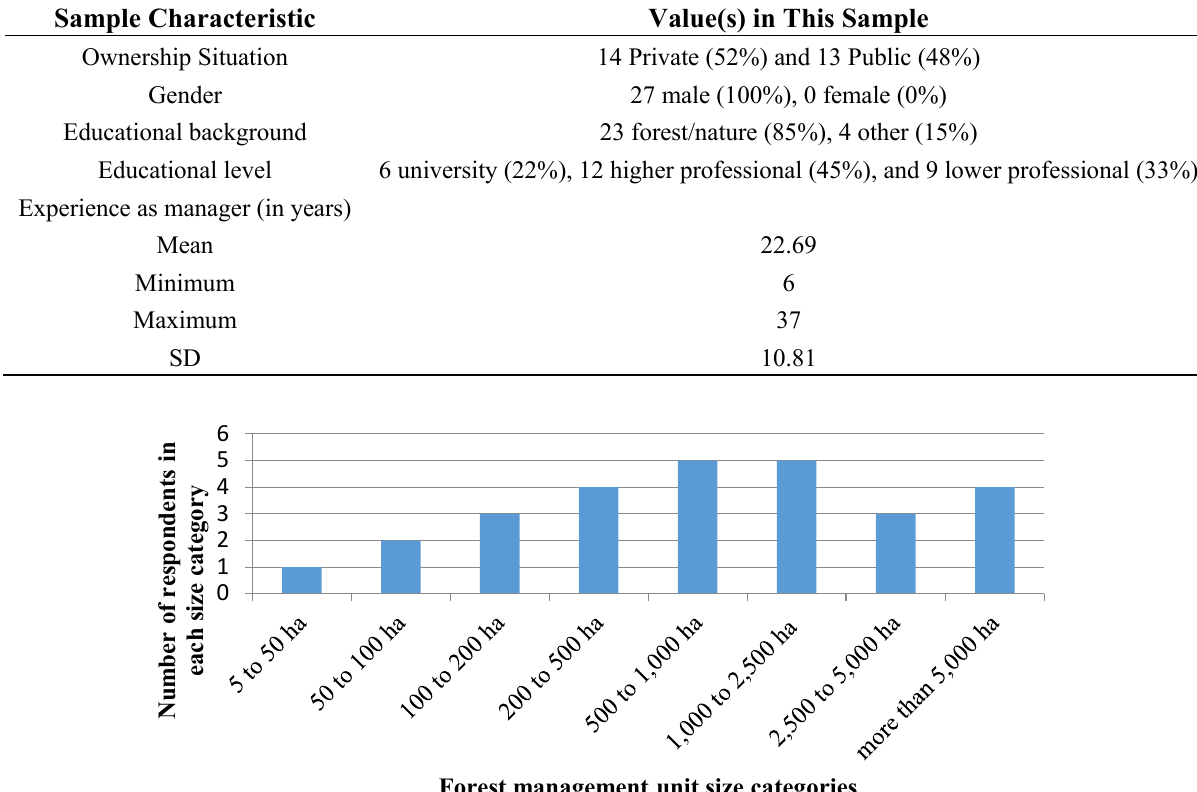
Table 1. Characteristics of the sample of forest managers ( N = 27).